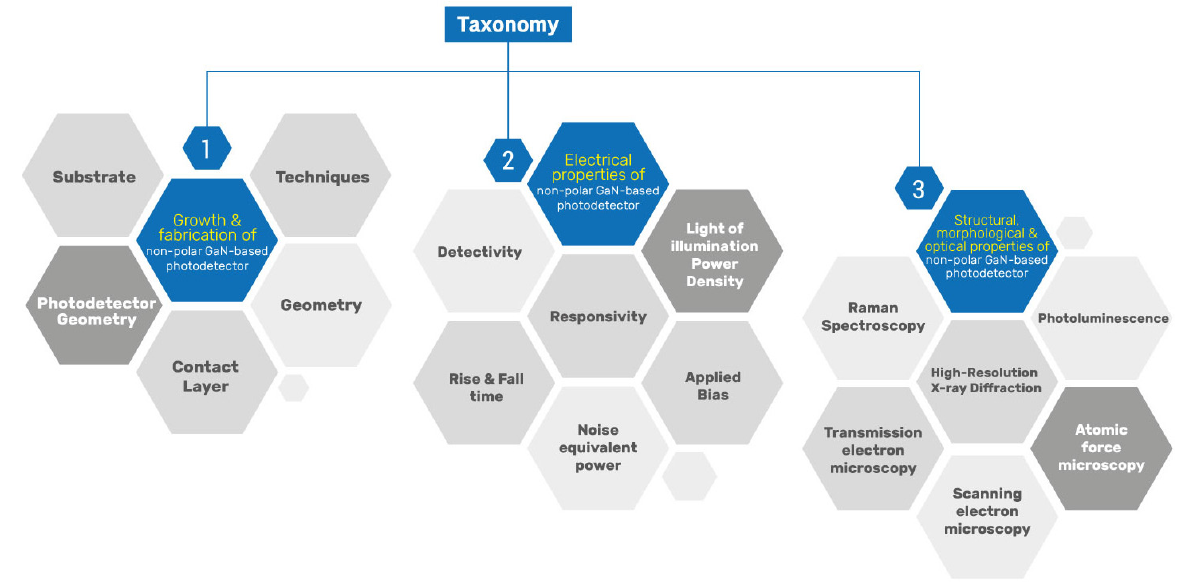
Figure 2. Taxonomy of the literature.